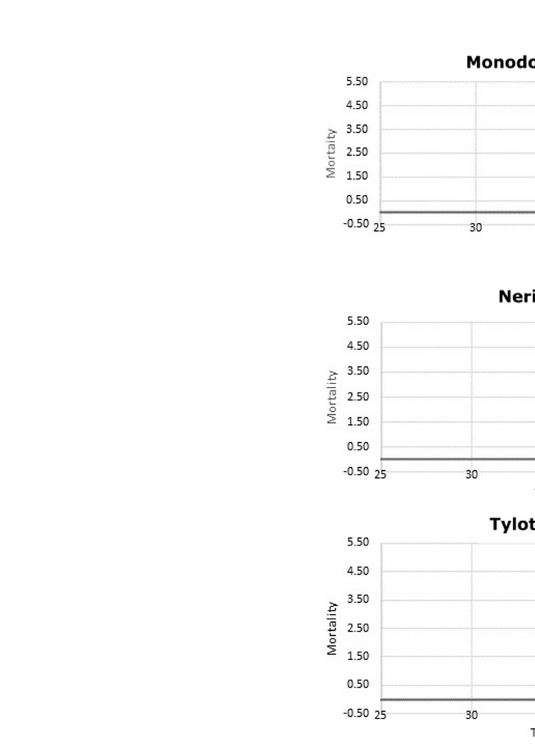
variation (Figure 4). The survival number of three gastropod species within 96 h of LT 50 test indicates that the majority of individuals of N. albicella and T. savignyi endured various temperatures for up to 96 h, thus indicating their higher tolerance to elevated temperatures. However, individuals of M.